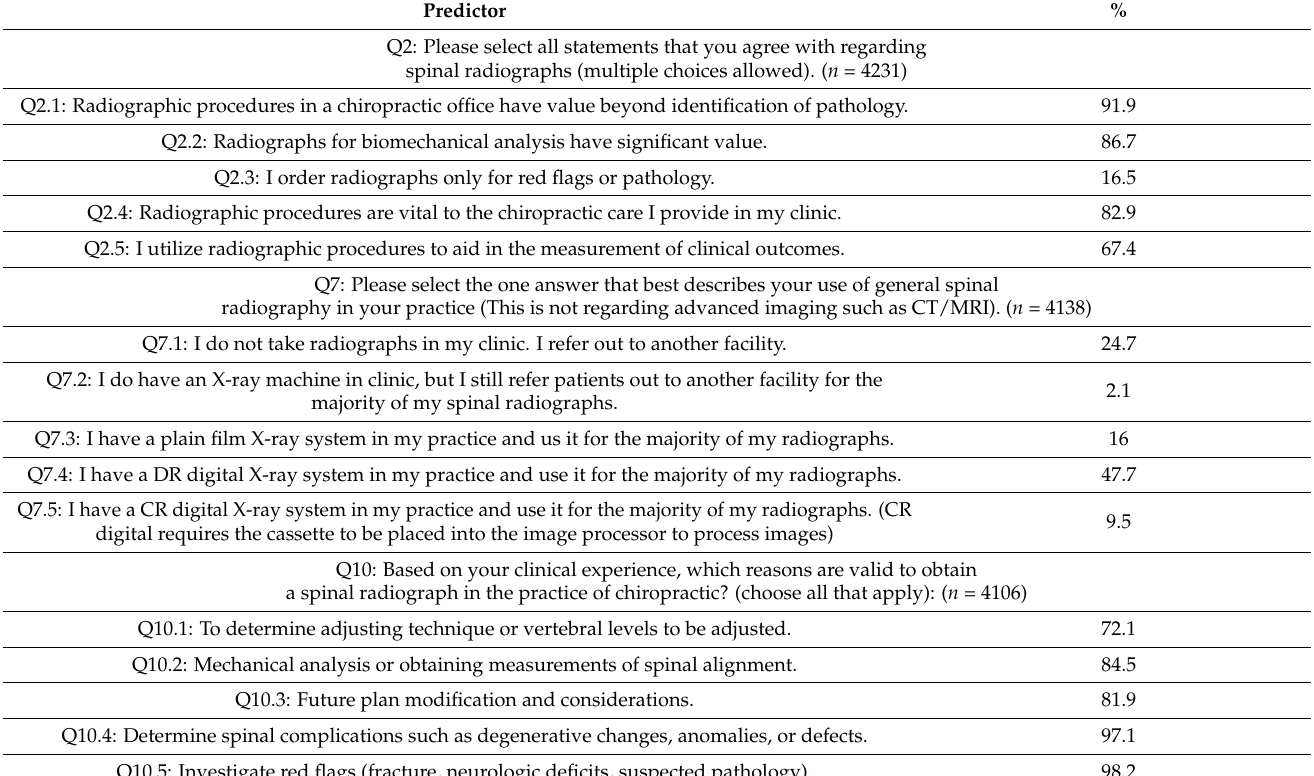
Table 2. Summary of binary survey responses (Questions 2, 7, 10). Predictor